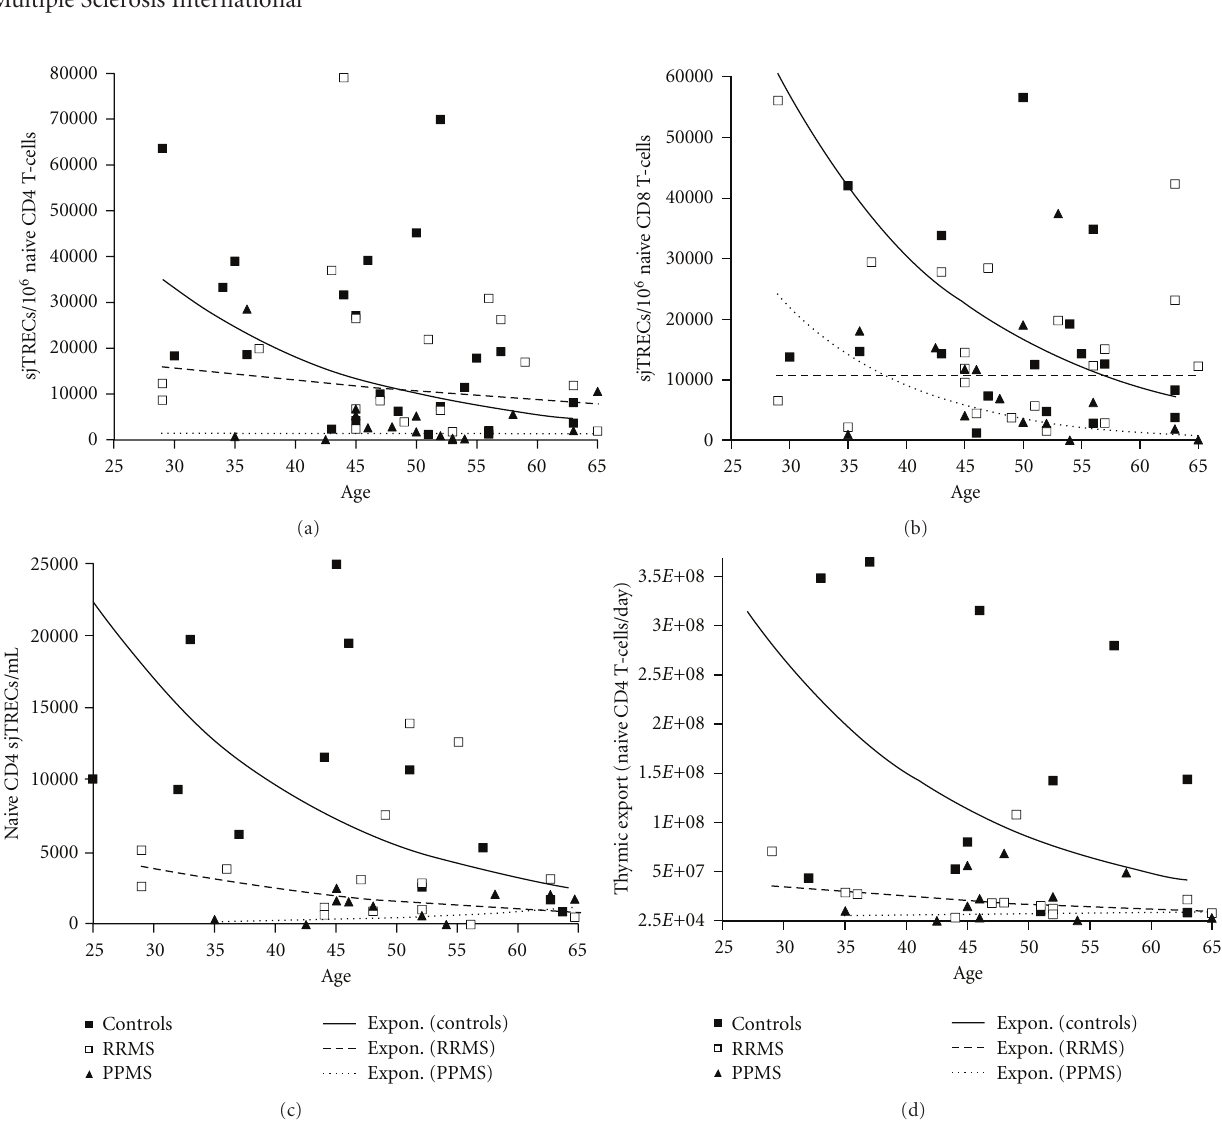
Figure 1: sjTRECs in controls and patients. (a) Na¨ıve CD4 sjTREC frequencies (sjTRECs/10 6 na¨ıve CD4 T-cells) decreased significantly with age only in controls ( P = 0 . 037). (b) Na¨ıve CD8 sjTREC frequencies decreased with age only in controls ( P = 0 . 037). (c) Total na¨ıve CD4 sjTREC numbers decreased exponentially with age only in controls ( P = 0 . 048). Median sjTRECs were higher in controls than in RRMS ( P = 0 . 03) or in PPMS ( P = 0 . 007) with a trend towards higher sjTREC numbers in RRMS versus PPMS ( P = 0 . 055). (d) Thymic export (na¨ıve CD4 T-cells/day) decreased with age only in controls ( r = − 0 . 564, P = 0 . 05). Both RRMS ( P = 0 . 005) and PPMS patients ( P = 0 . 004) had significantly reduced median daily thymic export compared to